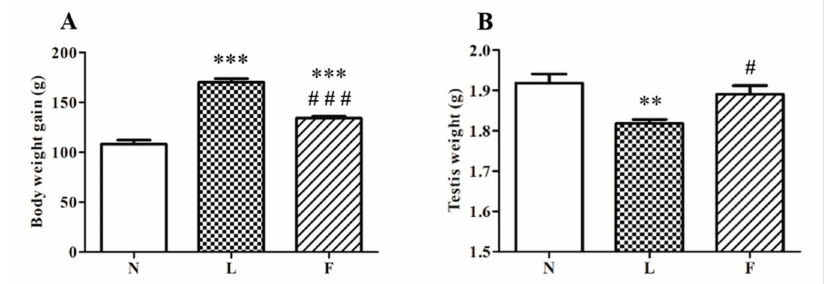
Figure 1. High lard (HL) and high fish oil (HFO) diets di ff erently a ff ect body weight gain ( A ) and testicular weight ( B ). Values are represented graphically as means ± standard error of the mean (SEM) of 8 di ff erent animals for each group. Significant di ff erences are shown: ** p < 0.01 vs. N; *** p < 0.001 vs. N; # p < 0.05 vs. L; ### p < 0.001 vs. L.